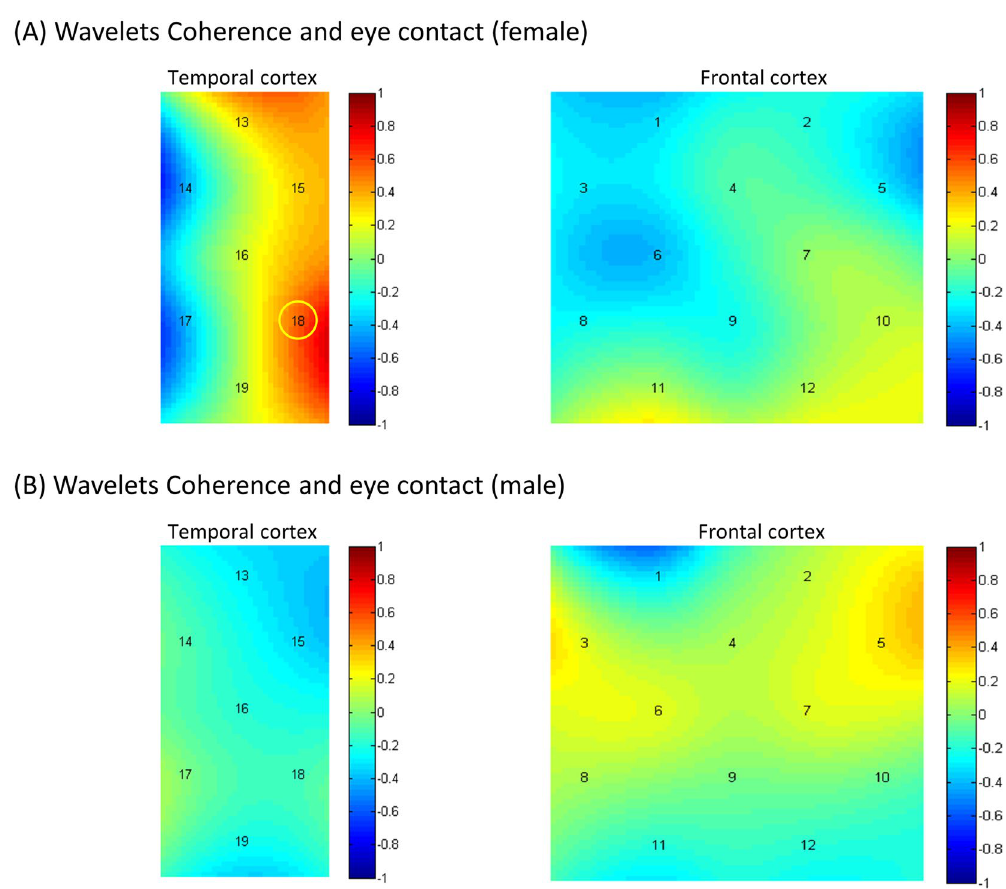
Figure 4. The Pearson correlation analyses of INS-Behavior. In all dyads, the deception INS and times of eye contact were positively correlated at channel 18 ( r = 0.547, p < 0.05, two-tailed). No significant correlation was found between honesty INS and eye contact; ( A ) the female dyads showed a significant correlation of deception INS and times of eye contact at channel 18 ( p < 0.01, two-tailed). ( B ) The male dyads showed no significant correlation of deception INS and times of eye contact at any channels. [Color bar represents r